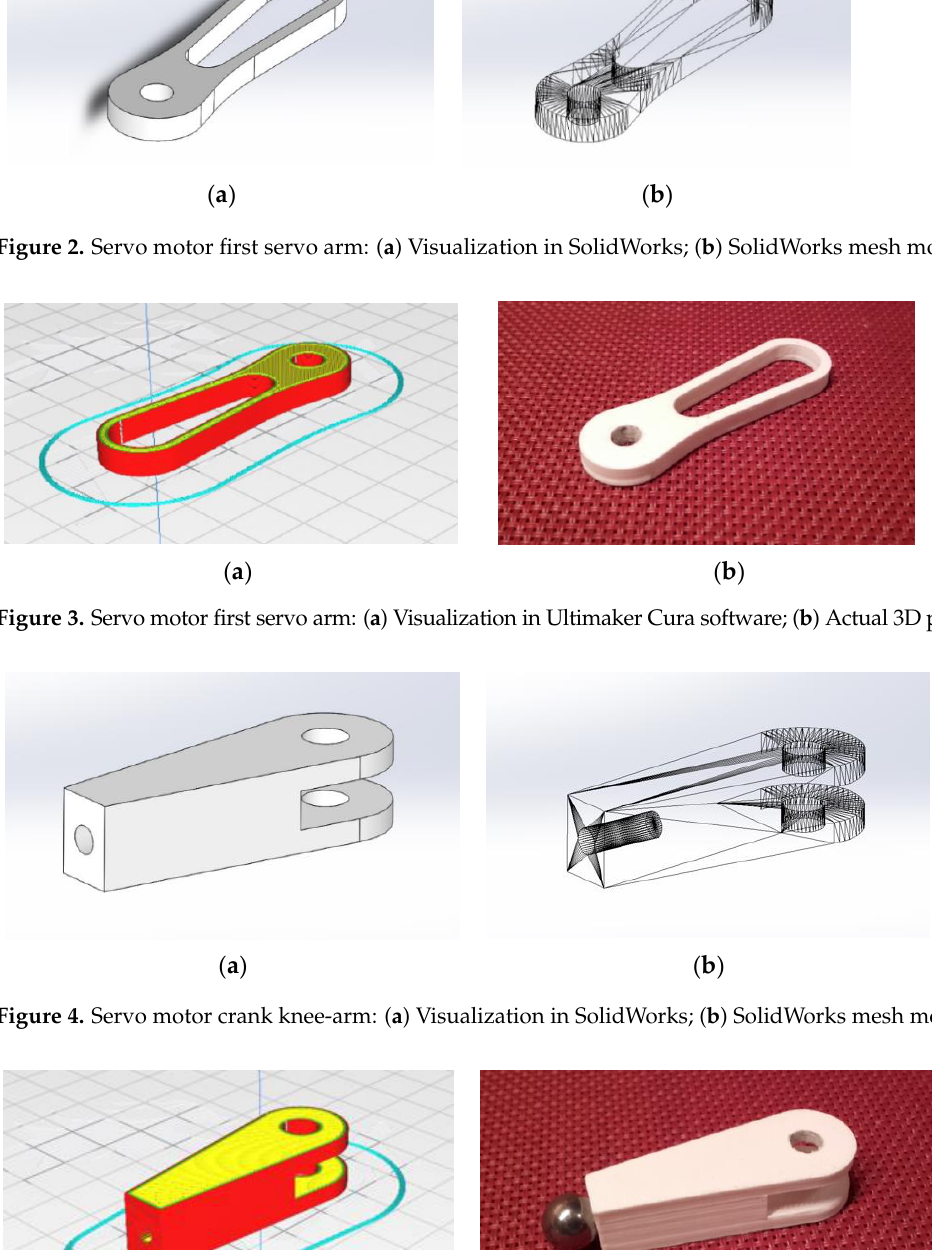
Figure 2. Servo motor first servo arm: ( a ) Visualization in SolidWorks; ( b ) SolidWorks mesh model.